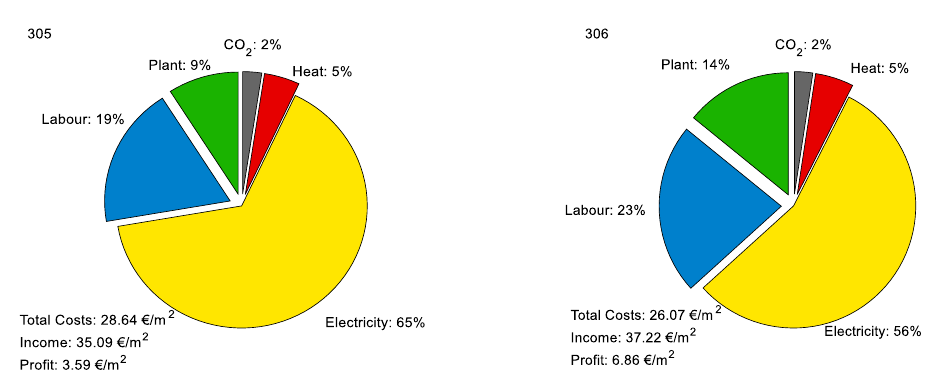
Figure A5. Net profit (€/m 2 ), different realized cost components (heat, electricity, CO 2 , plant and labor), income and net profit in different greenhouse compartments (301-306) during the experiment.